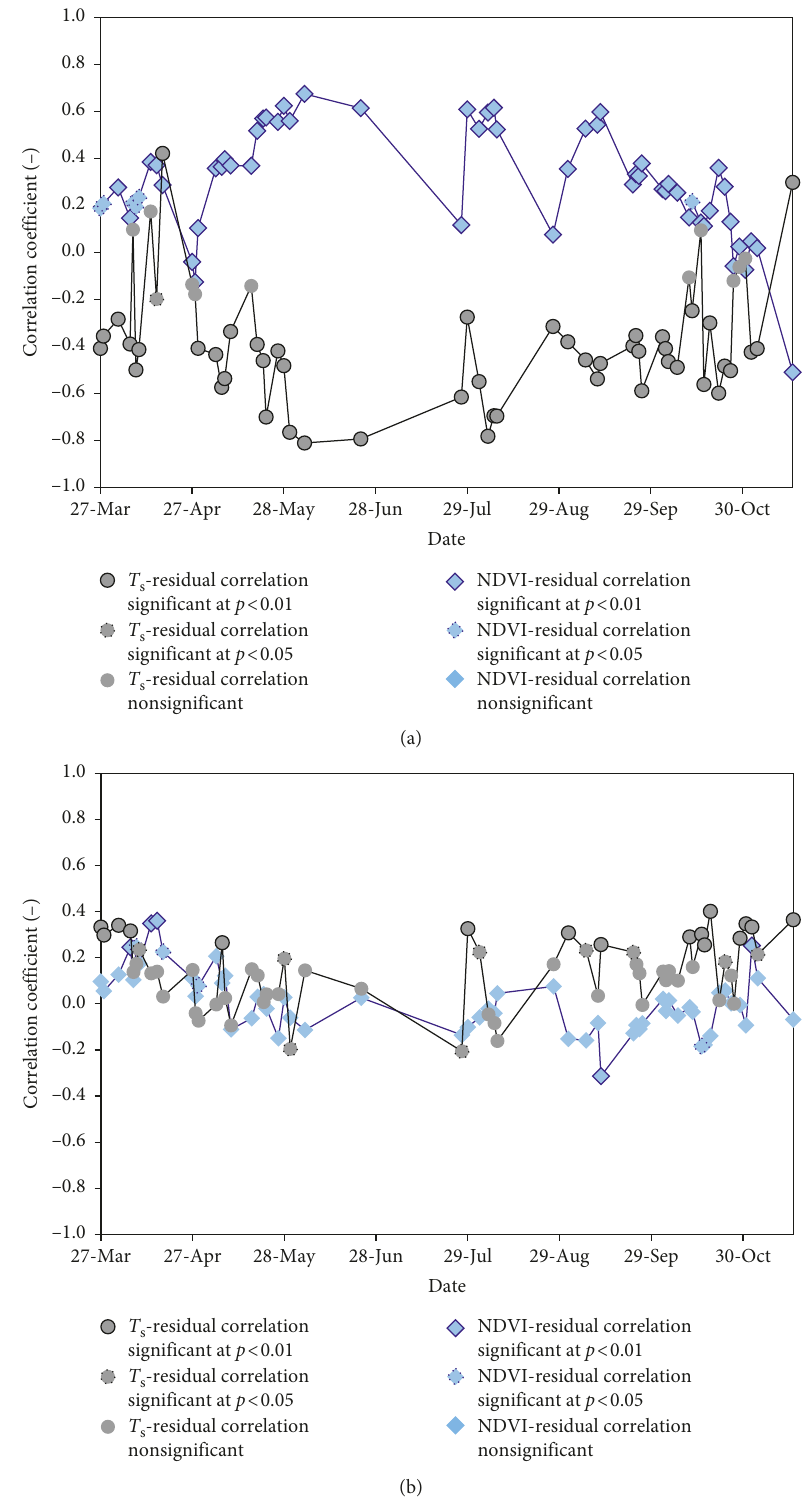
Figure 4: Correlation time series of the (a) polynomial regression and (b) SVR models between residual magnitudes and land surface ) and normalized vegetation difference index temperature ( T s